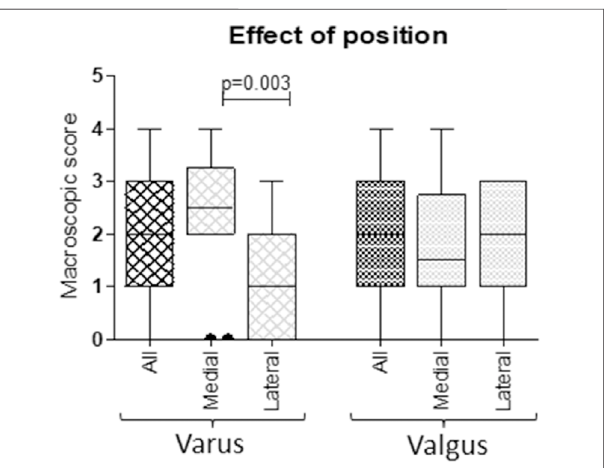
FIGURE 3 | (A) Microscopic histological score attributio n to condyle areas identi fi ed by position (medial, lateral, anterior, posterior) and OA degree